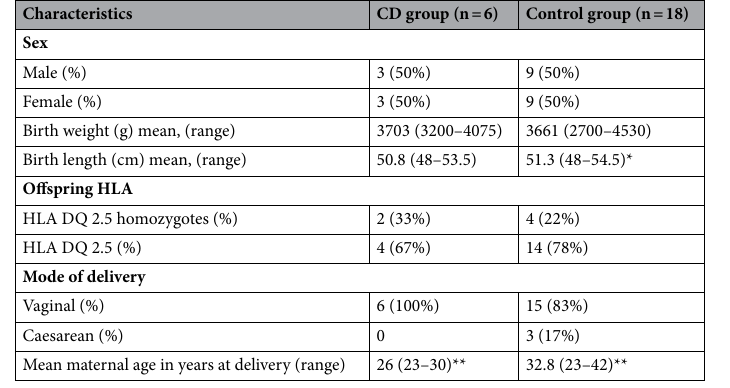
Table 4. General characteristics of the celiac disease (CD) group and the control group (*—data missing for one child; ** p =